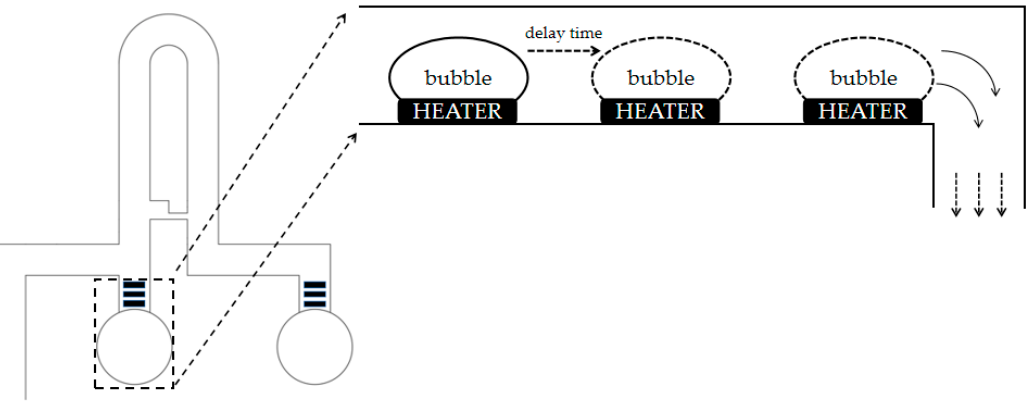
Figure 2. The thermal bubble micropump continuously produces thermal bubbles through the heater, and liquid fl ows under the action of thermal bubbles. and liquid flows under the action of thermal bubbles.